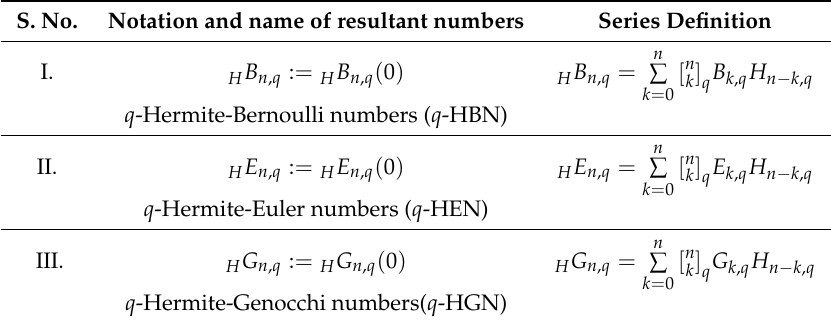
Table 4. Numbers Related to Certain Members of q -Hermite-Appell Family. S.